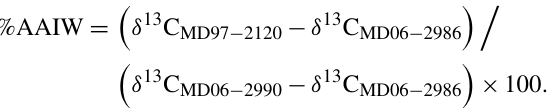
Data availability. All data has been published on Pangaea and can be found at https://doi.pangaea.de/10.1594/PANGAEA.938457 (Jones et al.,